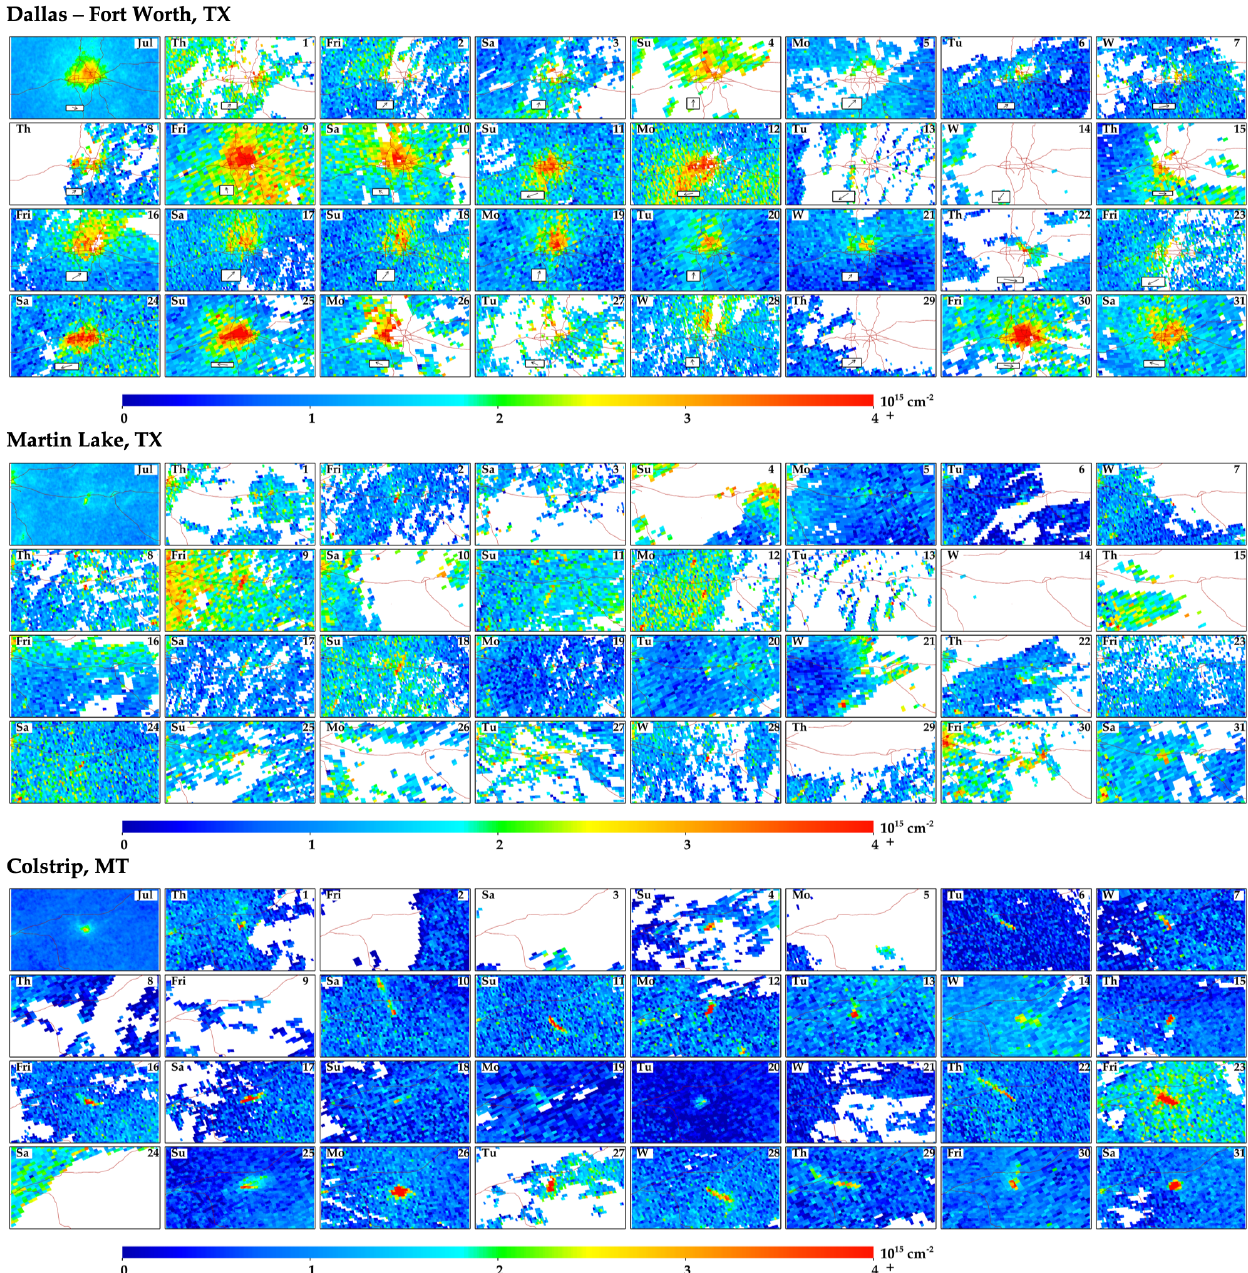
Figure D1. Daily TROPOMI NO 2 vertical column densities over three locations (Dallas–Fort Worth and Martin Lake and Colstrip power plants) during each day of July 2019; the July 2019 monthly average is denoted in the top left panel of each location aggregate.